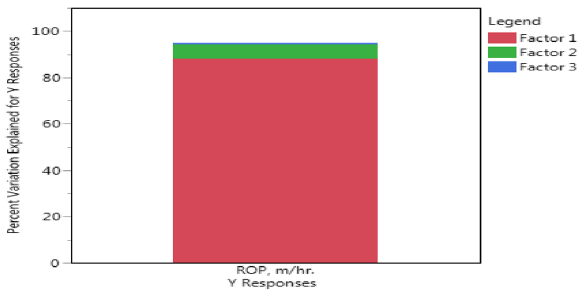
Fig. 30 Percent of variation explained by each factor for Y -variable (ROP model)